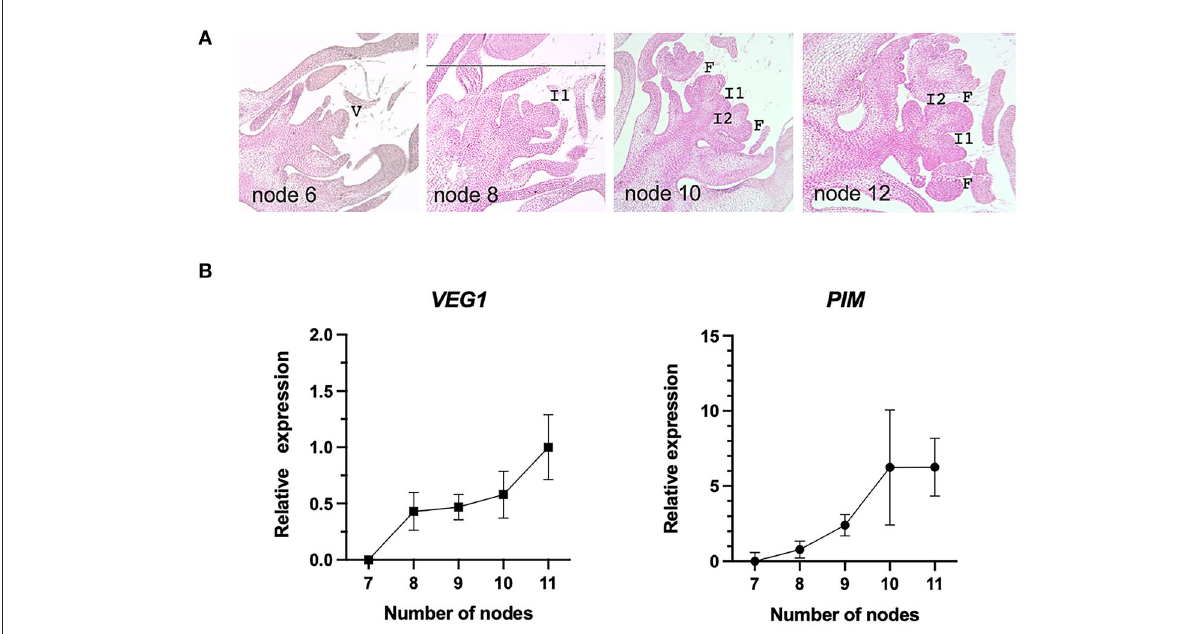
FIGURE2 Floral transition in the NGB5839 pea line. (A) Histological sections of shoot apices of NGB5839 pea plants that had produced 6, 8, 10, or 12 nodes. I2 and floral meristems are observed from 10-node plants. (B) Relative expression levels of VEG1 (left) and PIM (right), determined by RT-qPCR, of shoot apex samples collected from plants that had produced 7, 8, 9,10, or 11 nodes. Error bars correspond to standard deviation. V, shoot vegetative meristem; I1, primary inflorescence meristem; I2, secondary inflorescence meristem; F, floral